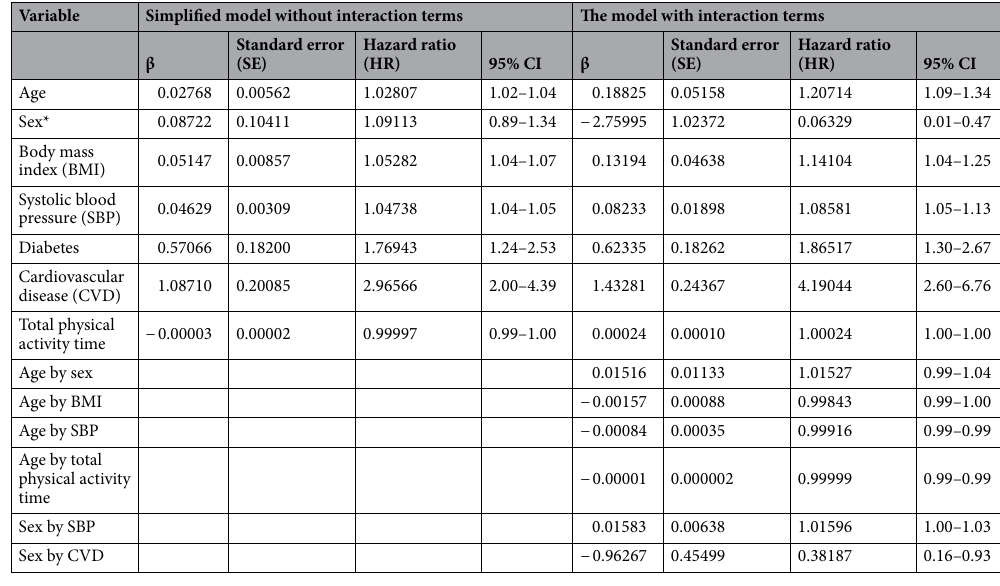
Table 3. Regression coefficients and hazard ratios for incident hypertension. *Male is the reference category.